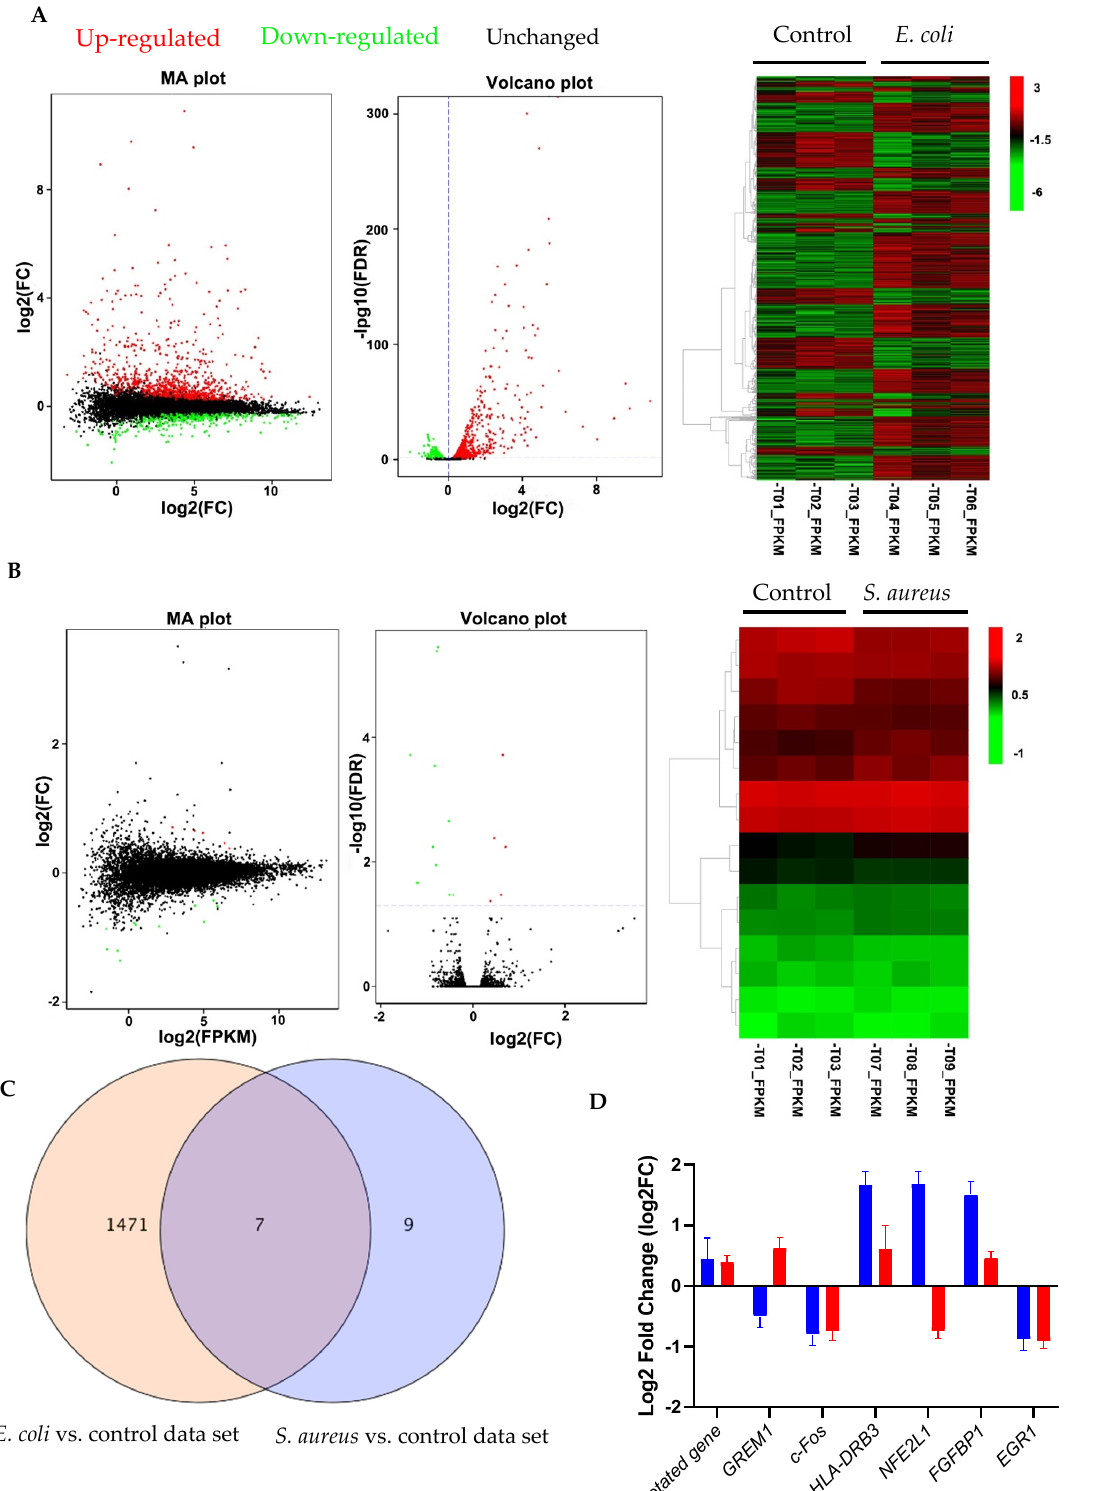
Figure 1. Gene expression profiling analysis of differential expression genes. ( A , B ) MA plots, volcano plots and hierarchical clustering showing differential expression profiles in primary cultures of bovine mammary epithelial cells (pbMECs) stimulated with heated-killed E. coli ( A ) or S. aureus ( B ) compared to unstimulated cells. Differentially expressed genes are established at log2(FC) > 0.1 and false discovery rate (FDR) < 0.05. FC, fold change; FPKM: Fragments Per Kilobase